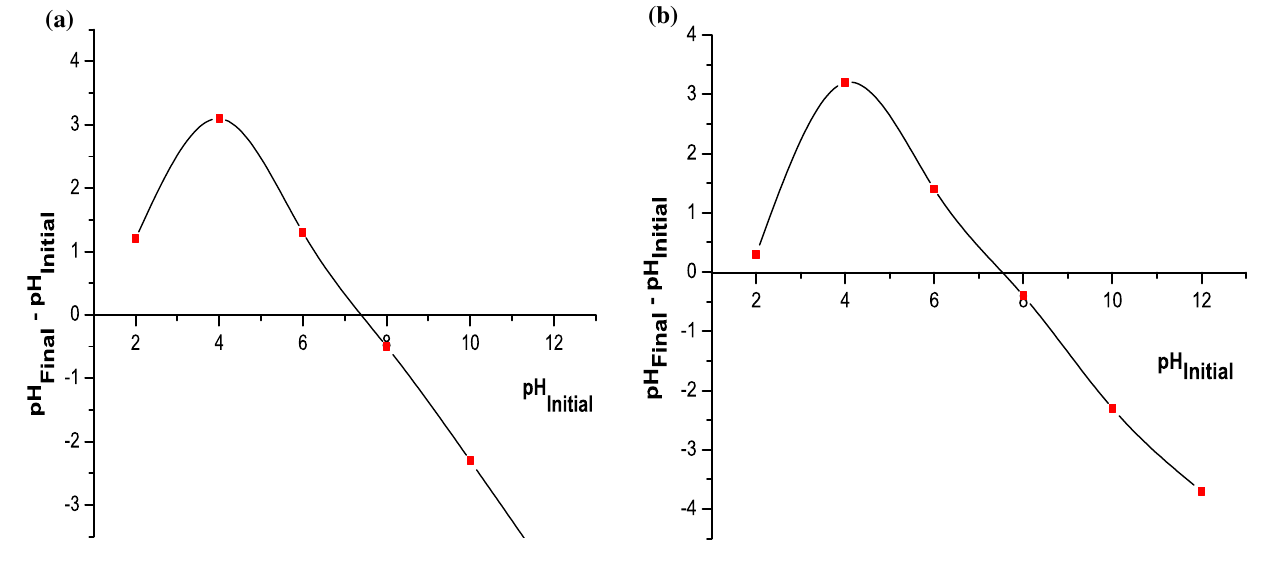
Fig. 3 pH point zero charge of a KOHAWS1 and b KOHAWS2